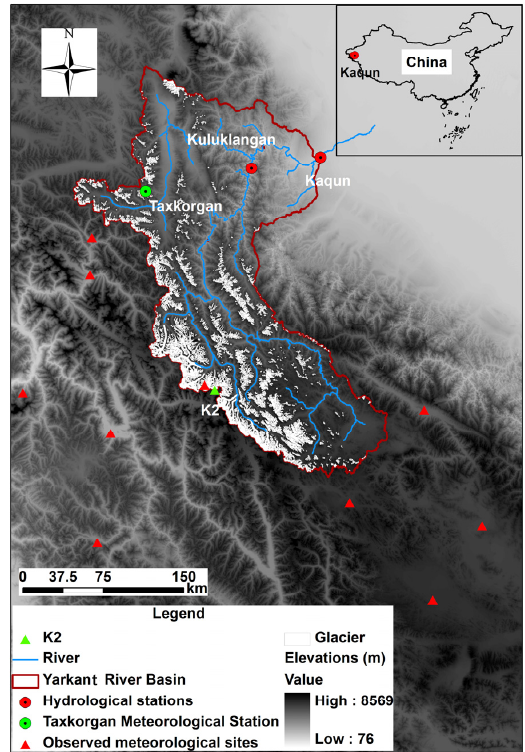
Figure 1. Map of the source region of the Yarkant River basin in the Karakoram Mountains.